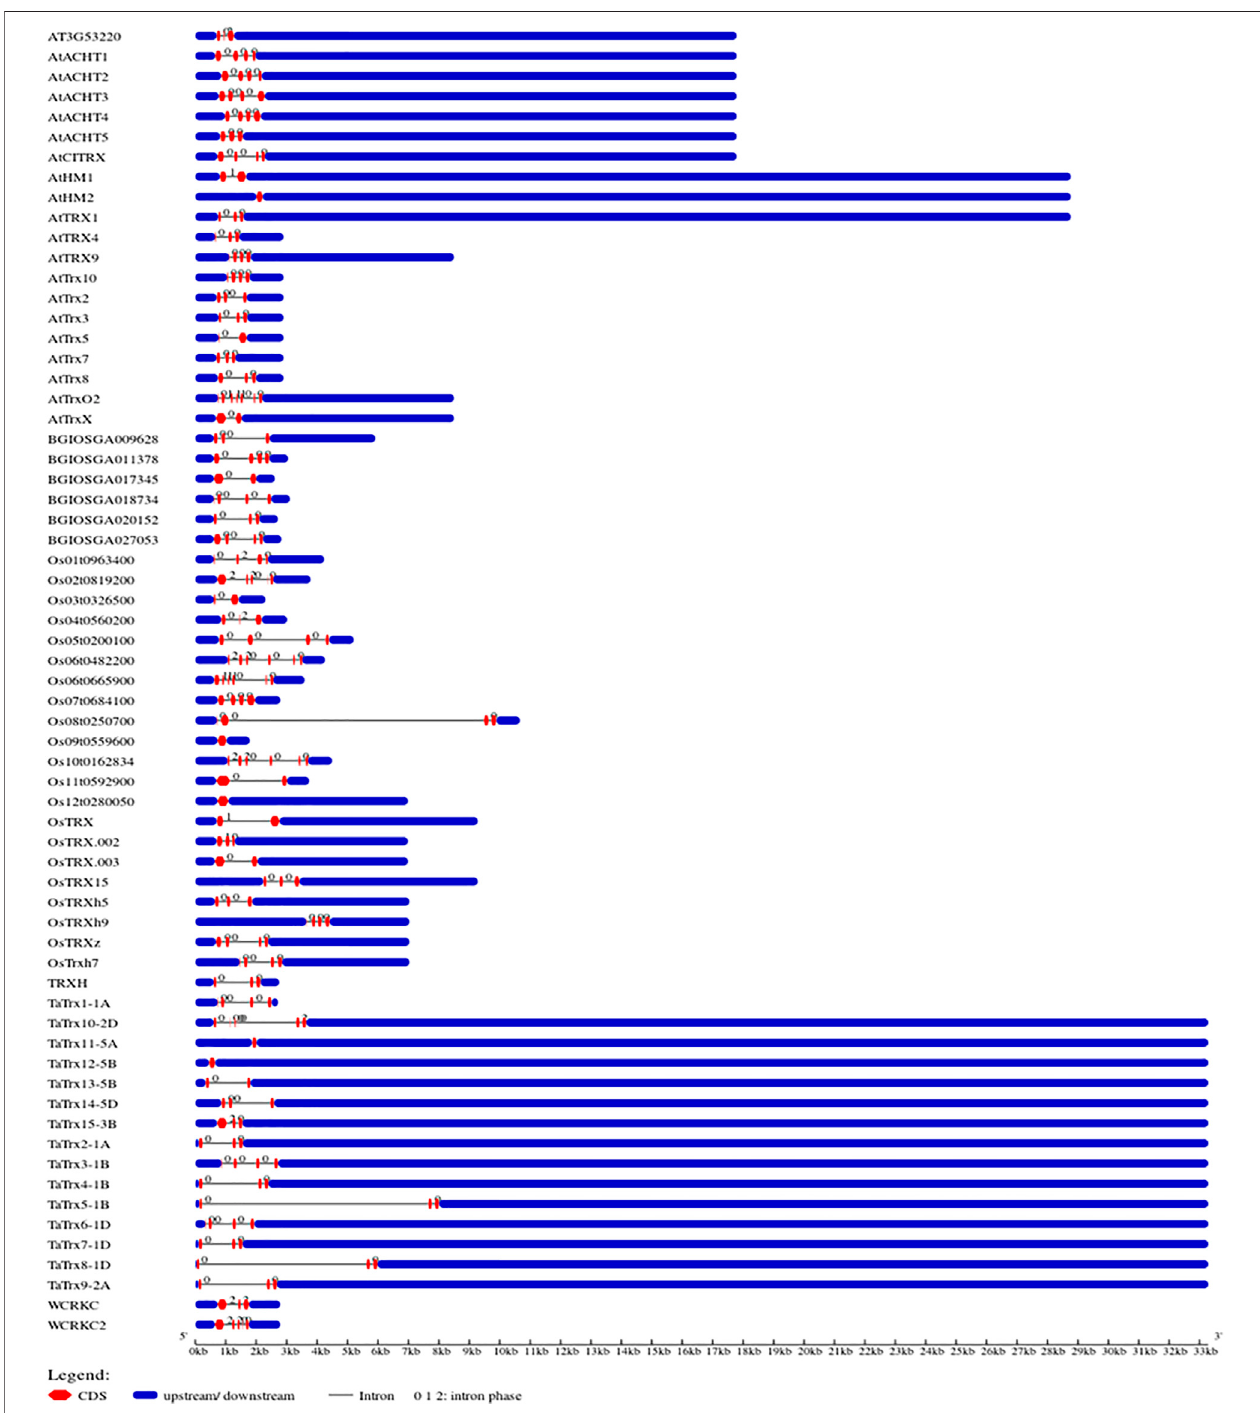
FIGURE 3 | Illustration of gene structure of identi fi ed wheat TaTrx genes along with Trxs from Arabidopsis and rice, showing the distribution of exons/introns, and exon phase created in the Gene Structure Display Server (GSDS v2.0) (http://gsds.cbi.pku.edu.cn/).